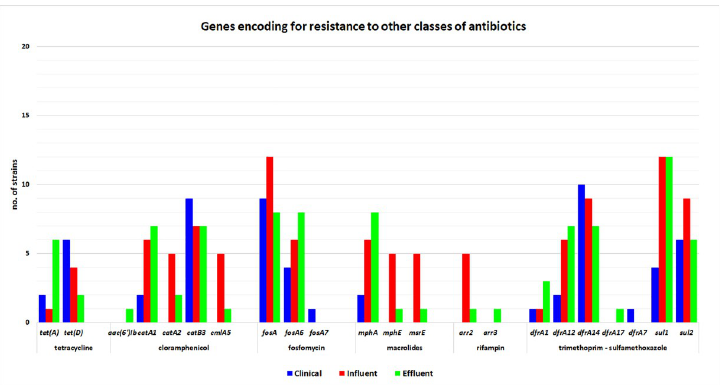
Fig 4. Resistance genes for other classes of antibiotics identified in aquatic and clinical